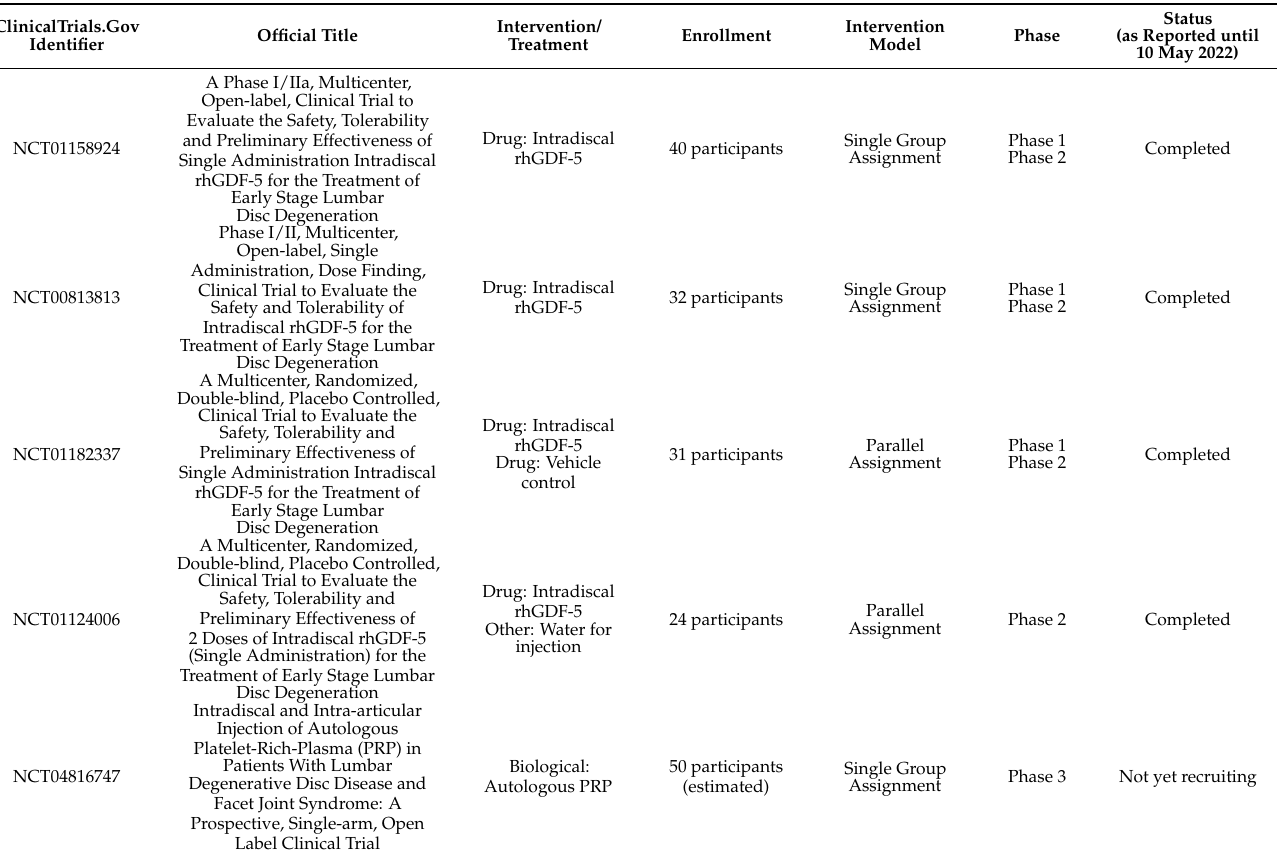
Table 2. Clinical trials involving growth factor therapy for treating intervertebral disc degen- eration. The studies were retrieved from clinicaltrials.gov with search keywords “Condition or disease = Intervertebral Disc Degeneration” and “Other terms = growth factor”; the relevant search results were manually